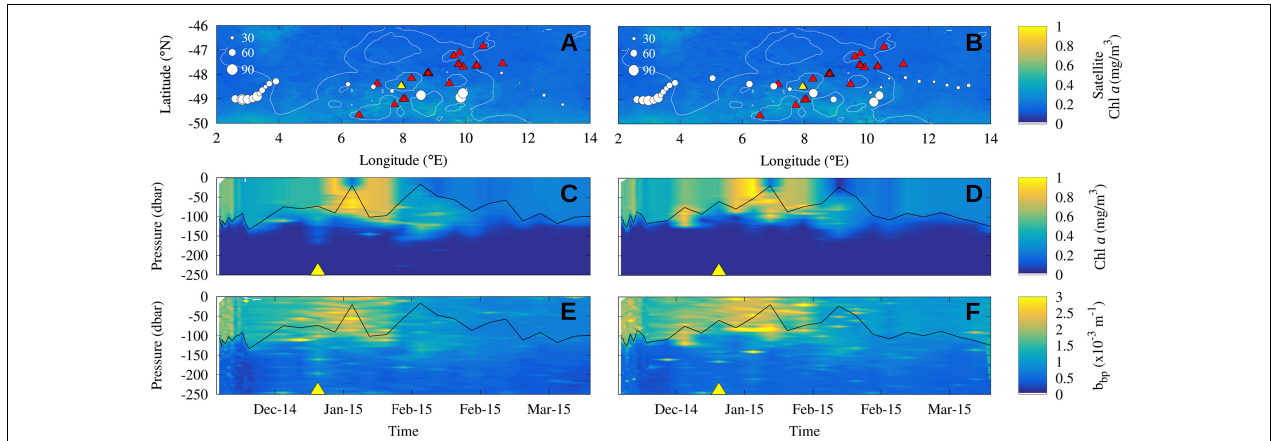
FIGURE 2 | Observed Chl a enhancement in the wake of seamounts by BGC-Argo WMO 6901688 (A,C,E) and WMO 6901585 (B,D,F) during the summer season 2014/2015. (A,B) Maps of the floats trajectory across the Shona Ridge System: each circle represents a vertical profile and its size is proportional to Chl a integrated over the mixed layer [the mixed layer depth is shown in the panels (C–F) with the solid black line]. Color scale shows the Chl a observed by satellite in January 2015 and red triangles the seamounts location. (C,D) Time series of the vertical distribution of Chl a concentration measured from the BGC-Argo floats along their trajectories. (E,F) Vertical profiles of backscattering measured from the BGC-Argo floats along their trajectories. Yellow triangles in the middle and bottom panels locate the time of the float closest position to the yellow seamount in the top panels. This may be interpreted as the contact of the BGC-Argo with the axis of the seamount